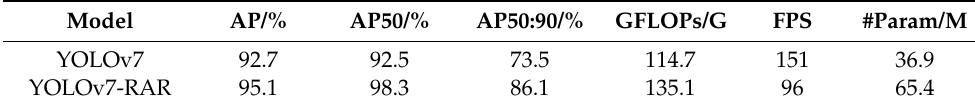
Table 7. Some excellent algorithms are selected to be compared with our model.